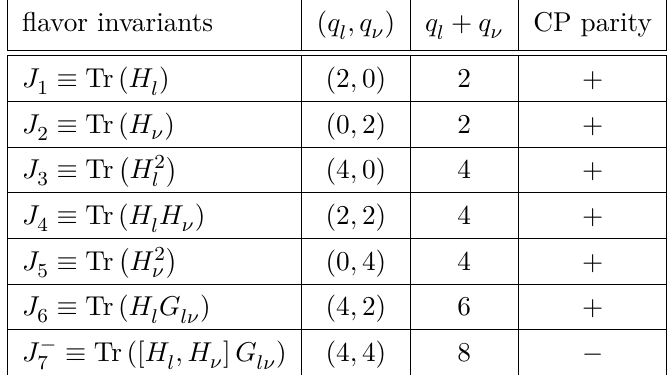
Table 1 . Summary of the basic flavor invariants in the generating set along with their degrees and CP parities in the case of two-generation leptons, where q respectively. Note that the commutator [ A, B ] ≡ AB − BA of two matrices has been